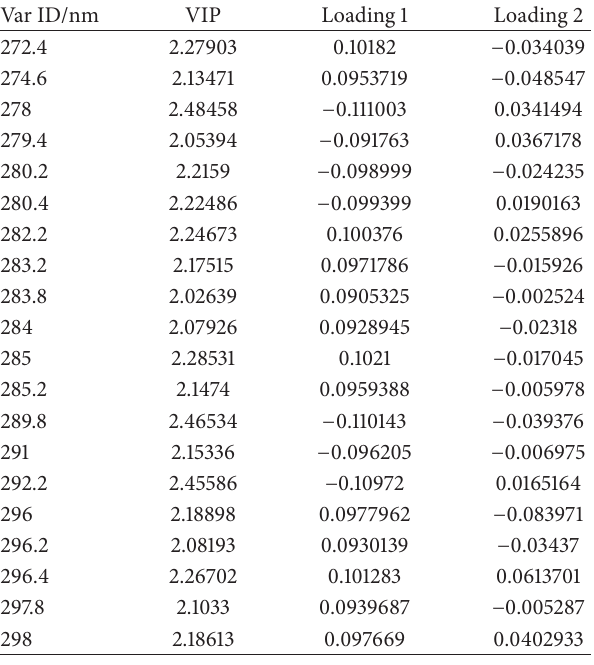
Table 2: VIPs and loadings of selected variables of PLS-DA.